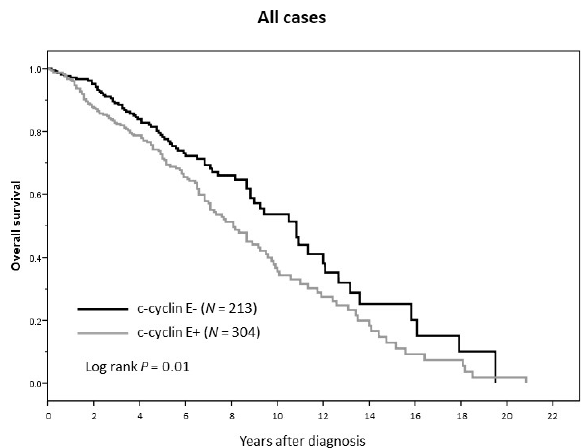
Figure 6. Overall survival (all cases) by cytoplasmic cyclin E status.